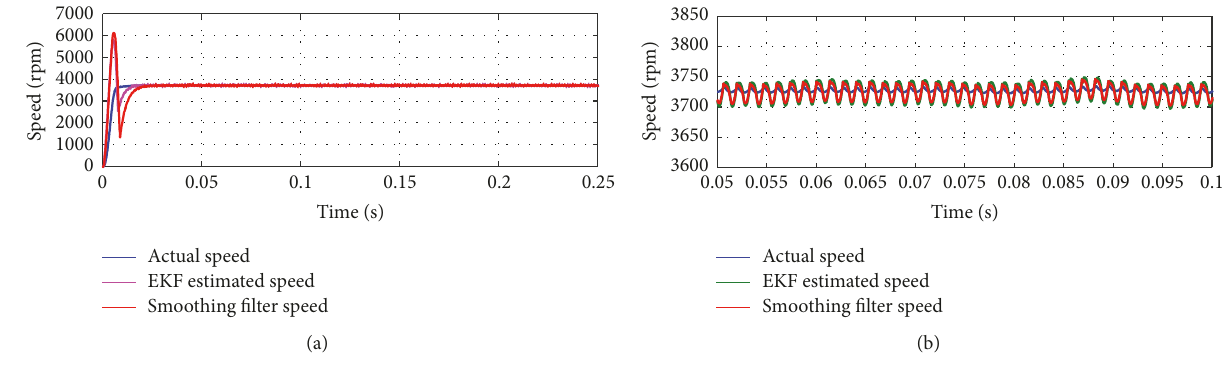
Figure 2: (a) Estimated and actual rotor speed at 𝑁 = 3700 rpm and 𝑇 𝑙 = 0.89 Nm. (b) Zoomed view of the speed curve.